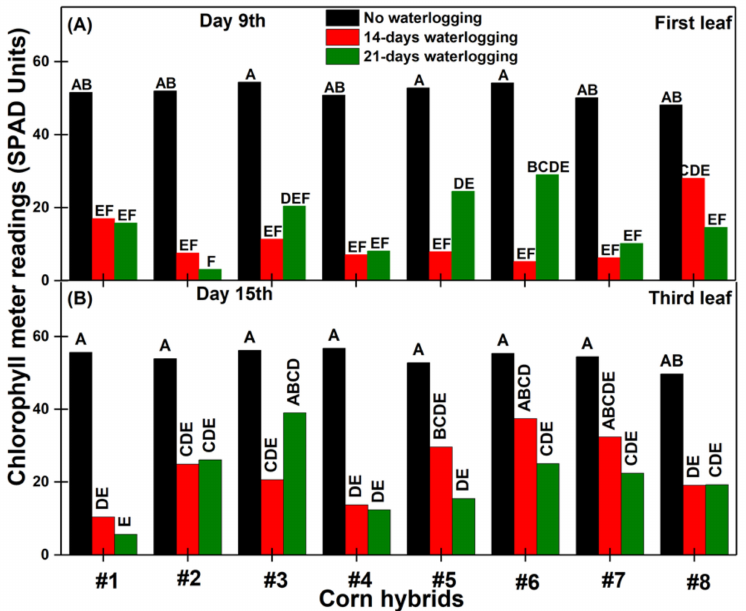
Figure 6. Chlorophyll meter readings for the first ( A ) and third ( B ) leaves of corn plants as affected by waterlogging duration among different hybrids. Same letters on bars indicate means do not differ significantly ( p < 0.10) based on Fisher’s least significant difference test.